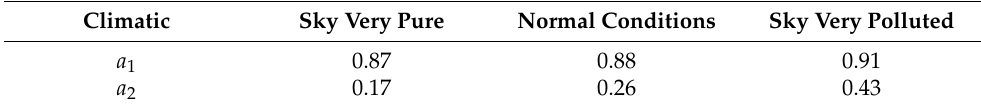
Table 1. The turbidity